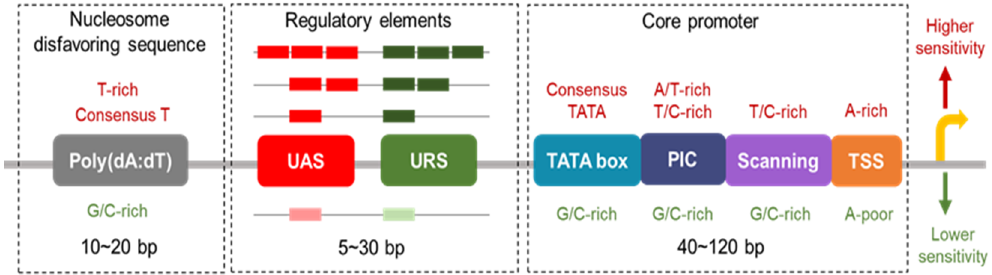
Figure 1. Promoter architecture in S. cerevisiae . The crimson rectangle represents the upstream activator sequence (UAS) with a higher activating activity and the pink rectangle is the UAS with a lower activity. Dark green represents the upstream repressor sequence (URS) with a higher repressing activity and light green represents a lower activity. The length of each element is labeled and 40–120 bp is the sequence length between the TATA box and the transcriptional start site (TSS), 5–30 bp is the UAS or URS length, and 10–20 bp is the length of the poly(dA:dT) tracts.